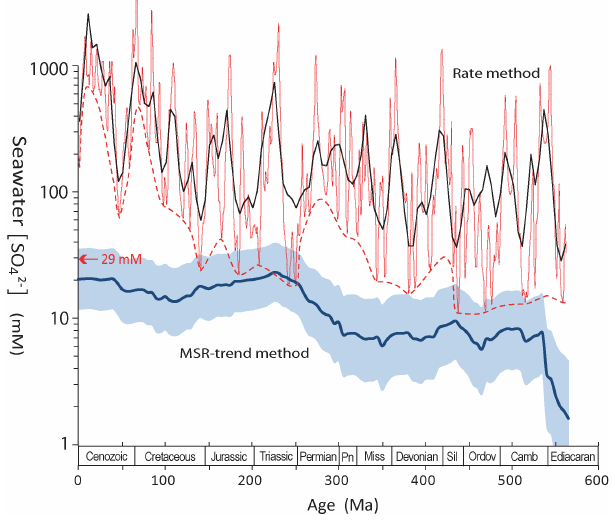
Figure 4. Phanerozoic seawater [SO 2 − trend method (Eqs. 6–8) yields an estimate of mean [SO 2 − (blue curve; bracketed by a ± 1 σ band). The rate method (Eqs. 3 and 4) yields the maximum possible [SO 2 − red curves show maximum values based on the low- and high- frequency Phanerozoic δ 34 S CAS records, respectively (Fig. 3a), and the dashed red line represents the lower envelope of the high- frequency curve. The modern seawater [SO 2 − shown by the red